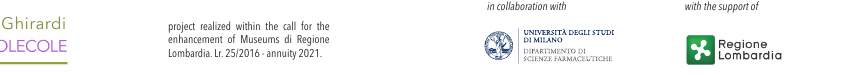
Figure 3. New labelling of Myrtus communis L. subsp. communis at the Ghirardi Botanic Garden (University of Milan, Toscolano Maderno, Brescia,